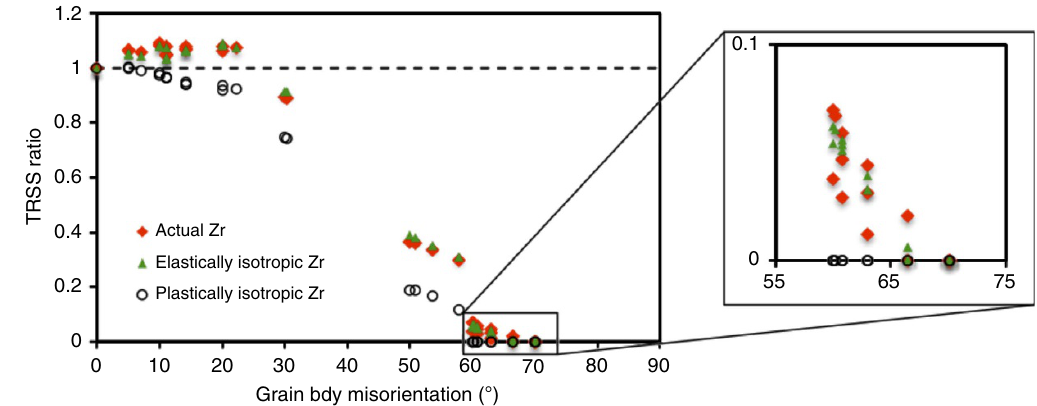
Figure 7 | Role of plastic anisotropy on ATP formation. Mapping of TRSS ratio in the region O as a function of neighbour grain boundary misorientation, for elastically isotropic Zr, plastically isotropic Zr and